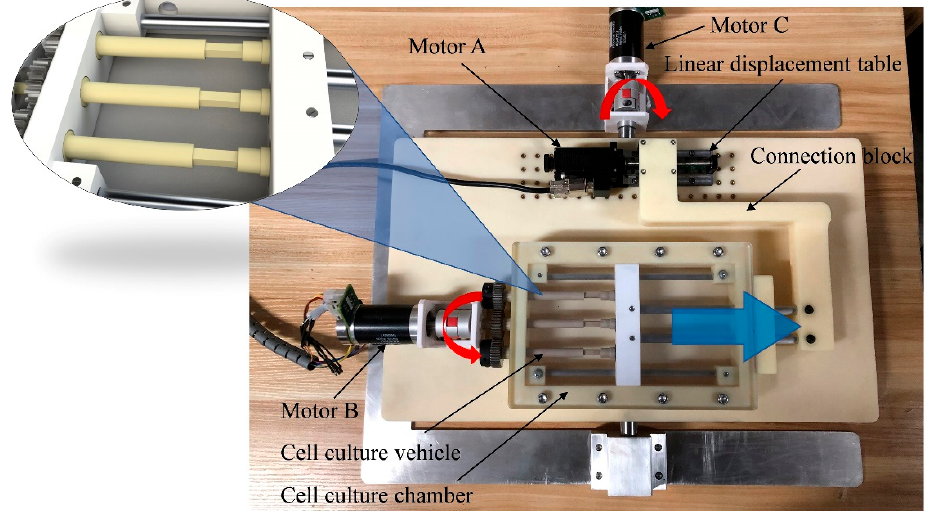
Figure 4. The three-dimensional nerve stretch growth device.